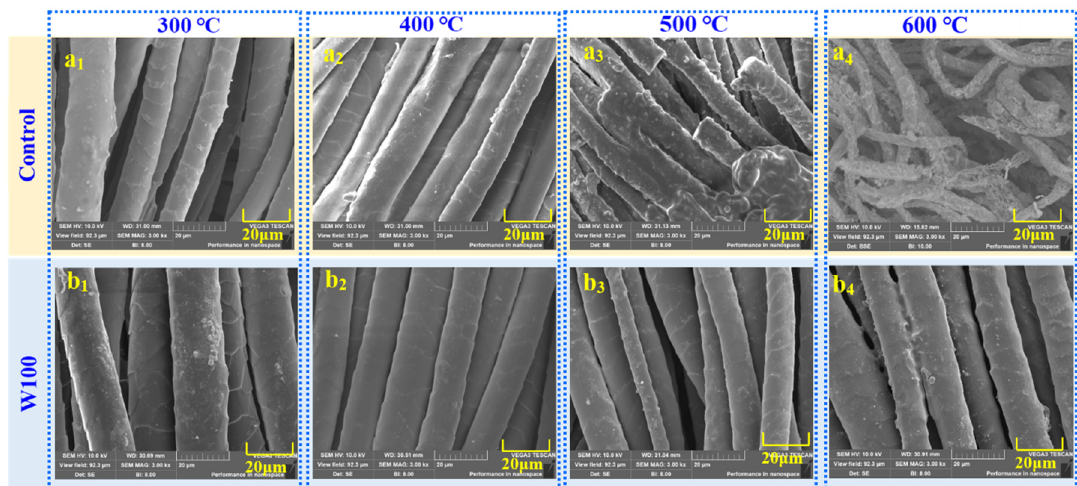
Figure 7. SEM of the control wool ( a 1 – a 4 ) and PBTCA-treated wool fabric (100 g/L, b 1 – b 4 ) after being heated at different temperatures for 10 min.